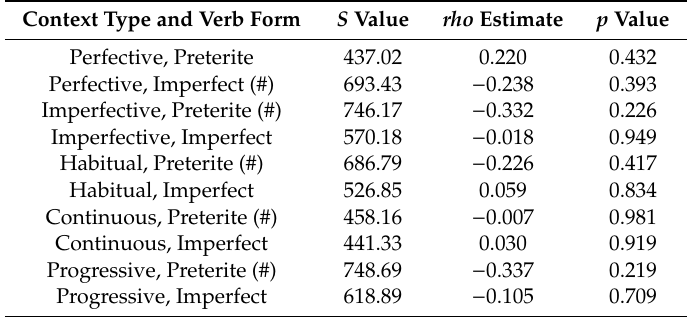
Table 5. Spearman’s rank correlations for children’s accuracy for each morpheme in each context and their relative exposure to Spanish.